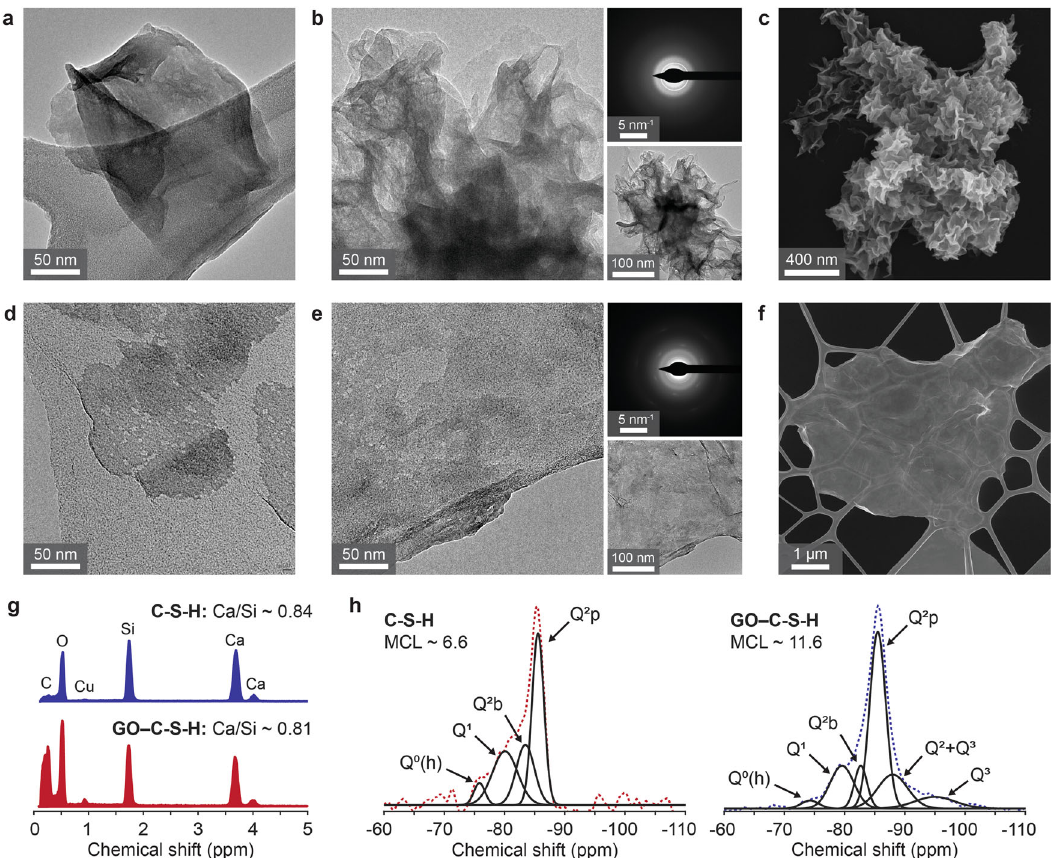
Fig. 2 Control of the growth of C – S – H sheets with GO. a TEM image of the folding deformations of a C – S – H sheet without a GO platform. b , c Loose packing of C – S – H sheets shown in b TEM and c SEM images. The top-right and bottom-right images in ( b ) show the selected area electron diffraction and lower-magni fi cation image of the same area, respectively. d TEM image showing the 2D geometry of a C – S – H sheet on the surface of GO. Defects (i.e. holes) are seen in the C – S – H sheet. e TEM image showing the in-plane C – S – H layer formed on the surface of GO. The top-right and bottom-right images in ( e ) show the selected area electron diffraction pattern and the lower-magni fi cation image of the same area, respectively. f SEM image demonstrating the 2D morphology of a single GO – C – S – H mesosheet. g EDS analysis of the C – S – H sheets and GO – C – S – H mesosheets. h 29 Si MAS NMR spectra and MCL of C – S – H formed without and with the GO